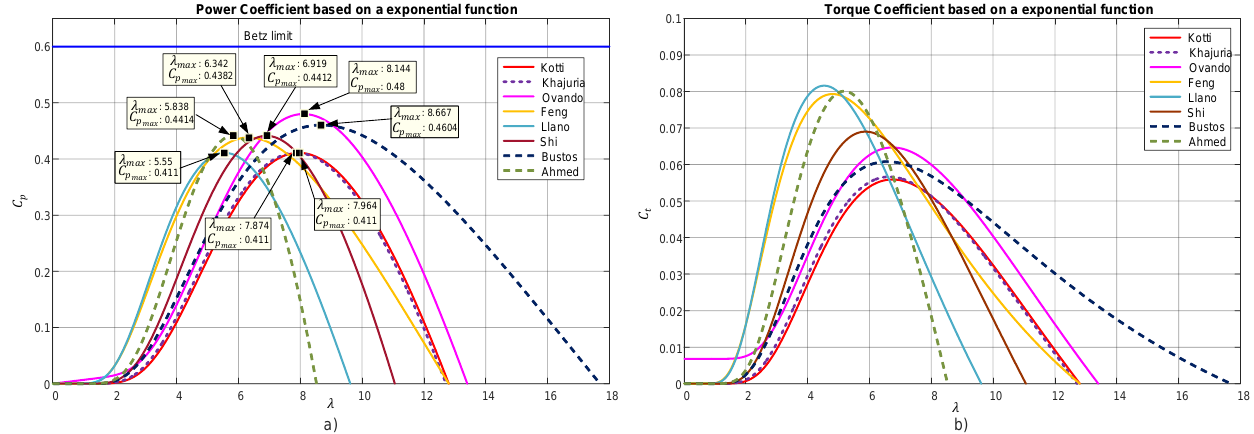
Figure 11. Coefficients based on an exponential function; ( a ) power coefficient, ( b ) torque coefficient. Kotti [30,31], Khajuria [32], Ov ando [33 – 41], Feng [42 – 47], Llano [48], Shi [19,50], Bustos [51], Ahmed [52].